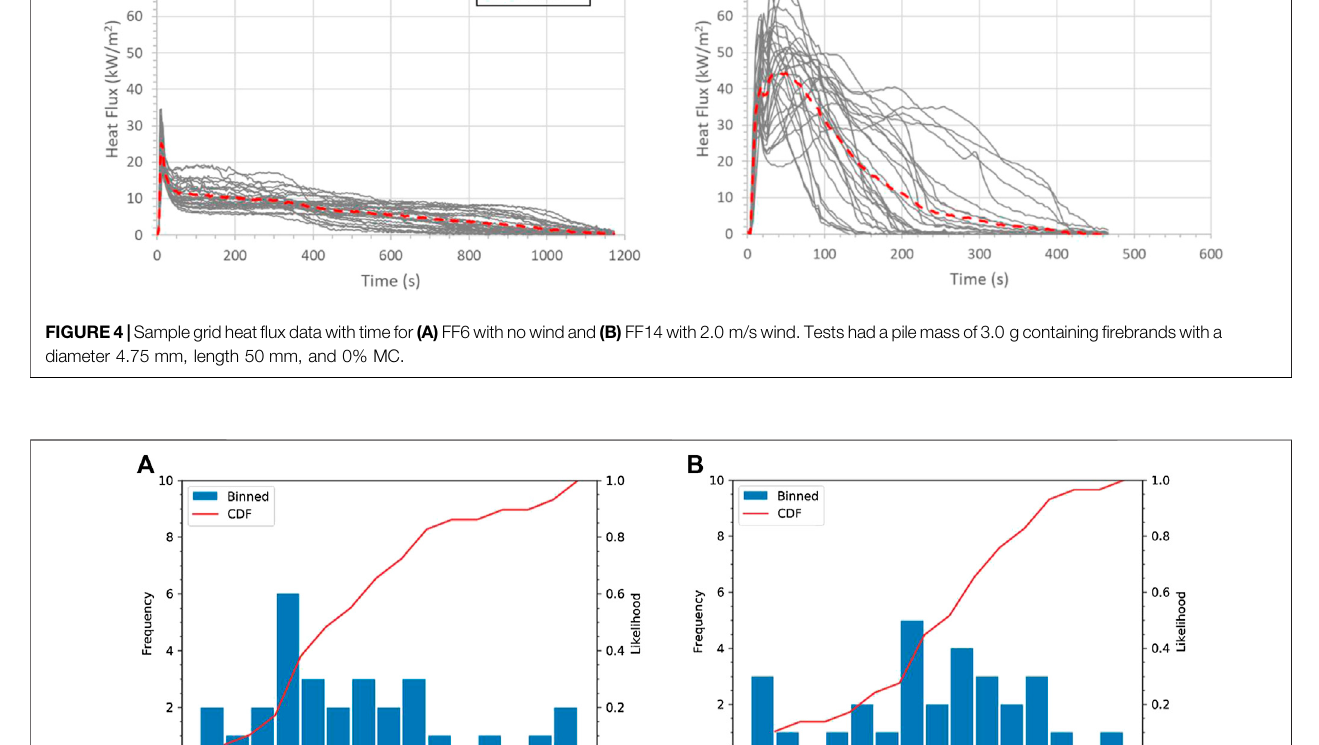
Table 9 . It was found that for low density wood (Yellow Poplar, ρ (cid:2)